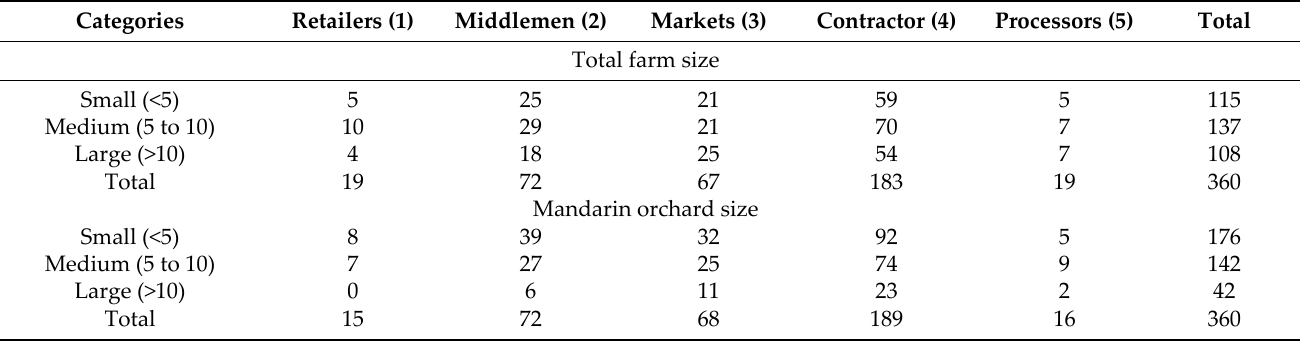
Table 2. Distribution of mandarin farmers across different supply